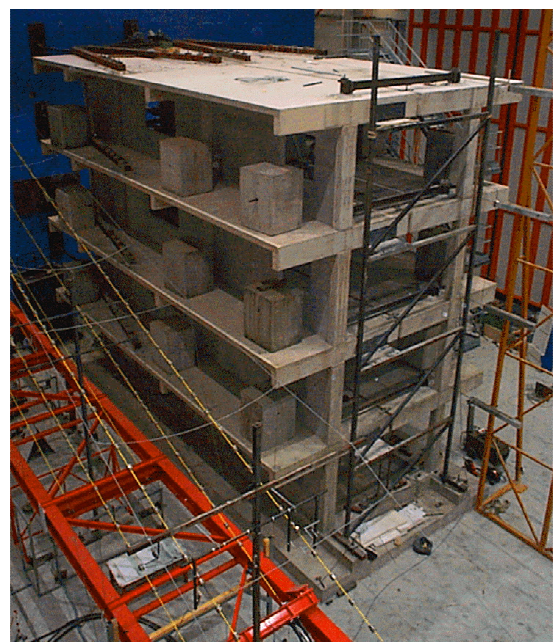
Figure 8. General view of the full-scale 4 storey RC frames.